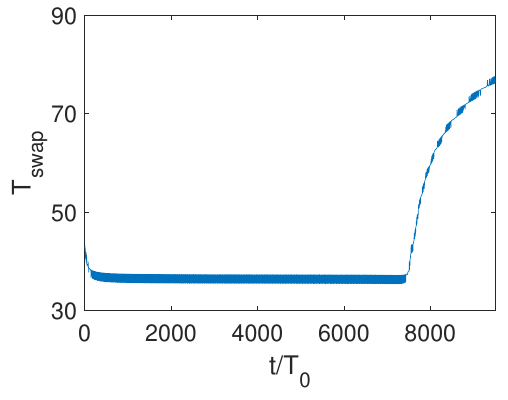
Figure 10. Charge-swapping period T swap . T 0 = 2 π/m = 2 π is roughly the oscillation period of the field φ . All the settings are identical to figure 8.